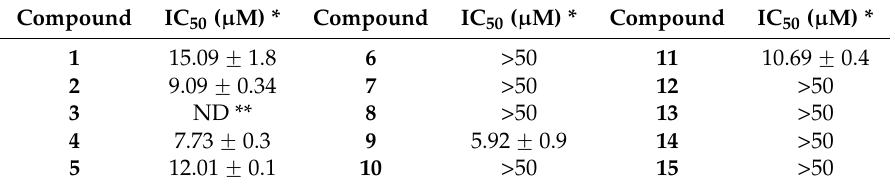
Table 2. Inhibitory effects of 1 – 15 isolated from the stem bark of A. altissima on nitric oxide production in LPS-induced RAW 264.7 cells.